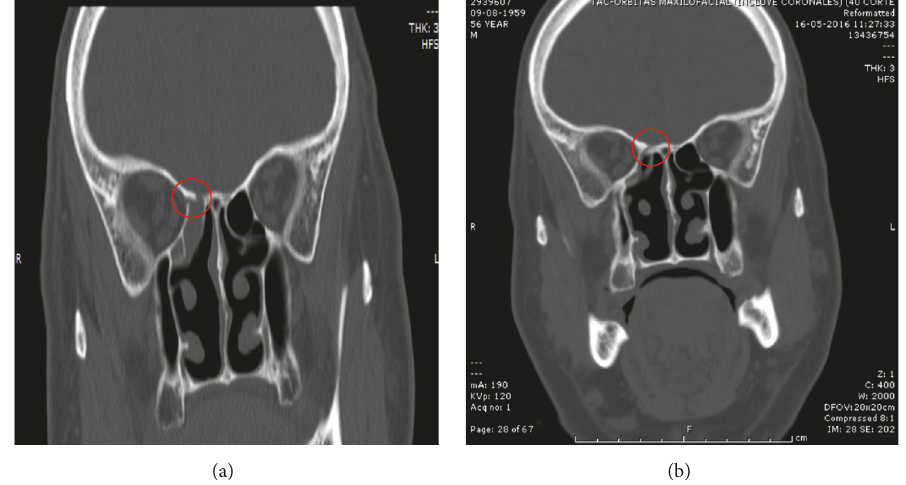
Figure 4: Case 1. (a) Preoperative CT scan showing a CSF leak in the right cribriform plate. (b) Seven-month postoperative CT showing a less dense bony closure of the surgical defect.